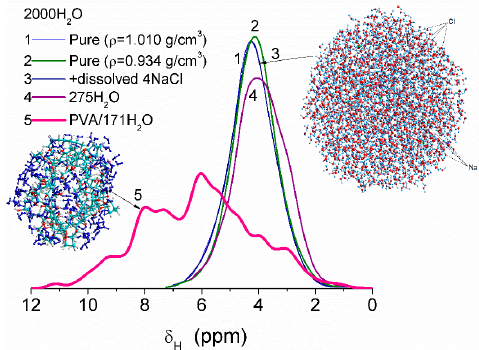
Figure 8. Chemical shifts of water molecules in clusters: pure (curves 1, 2, and 4), with dissolved NaCl (curve 3) and bound to PVA fragments cross-linked by glutaraldehyde (curve 5). Computational models are based on calculations using PM6 and PM7 methods and correlation functions based on DFT and PM6 or PM7 calculations of the same water clusters (adapted from [13]). The water structure in HG produced from Salvia nutlets was analyzed using DSC [60]. Adding 0.1 M urea or alkali-metal salts did not influence the position or intensity of sharp endothermic peaks. The distribution of freezable (i.e., NBW + WBW) and non-freezable (SBW) waters had small